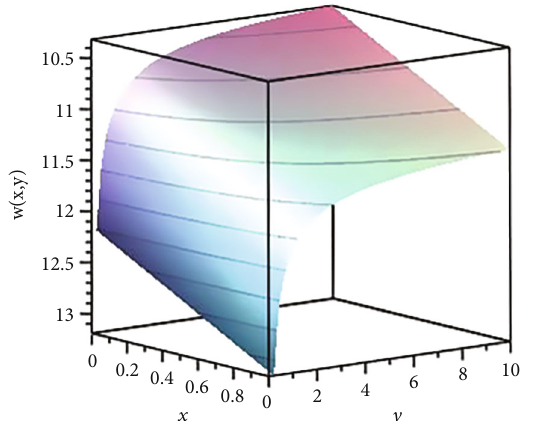
Figure 7: 3D plot of (24) for t = 10 . ffiffiffiffiffiffiffiffiffiffiffiffiffiffiffiffiffiffiffiffiffiffiffiffiffiffiffiffiffi